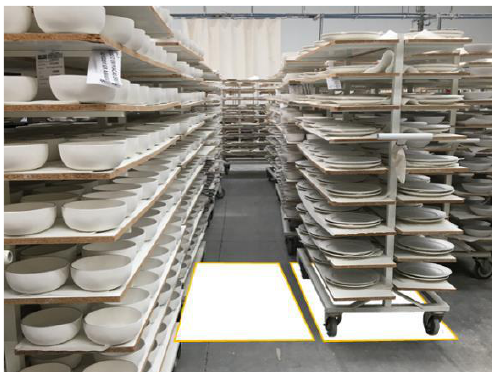
Figure 4. Space between cars.